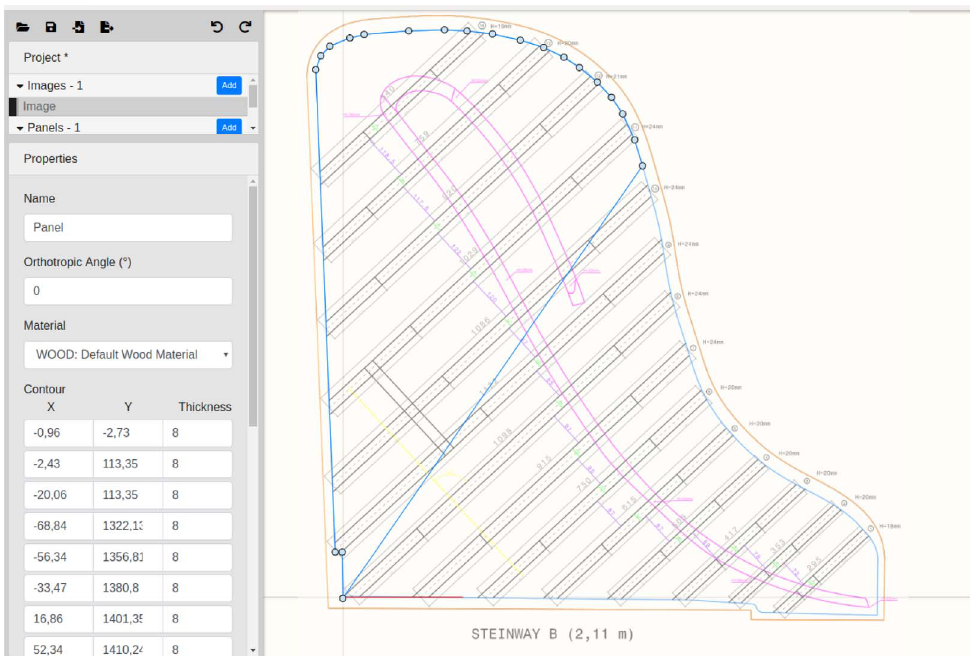
Figure 2. Screenshot of the MAESSTRO GUI during the design of a panel contour.